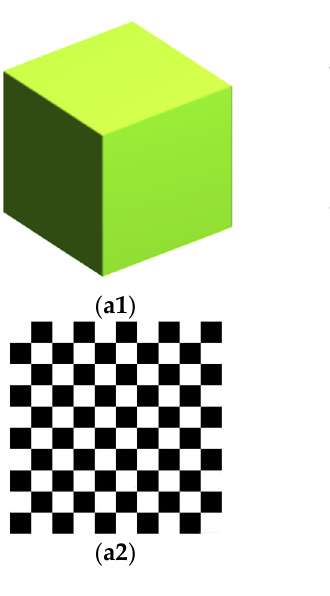
Figure 1. Schematic diagram of the distortions of a 3D cube and a 2D checkerboard: ( a1 ) original image; ( b1 ) pincushion distortion; ( c1 ) barrel distortion; ( d1 ) ripple distortion; ( a2 ) original image; ( b2 ) pincushion distortion; ( c2 ) barrel distortion; ( d2 ) ripple distortion.